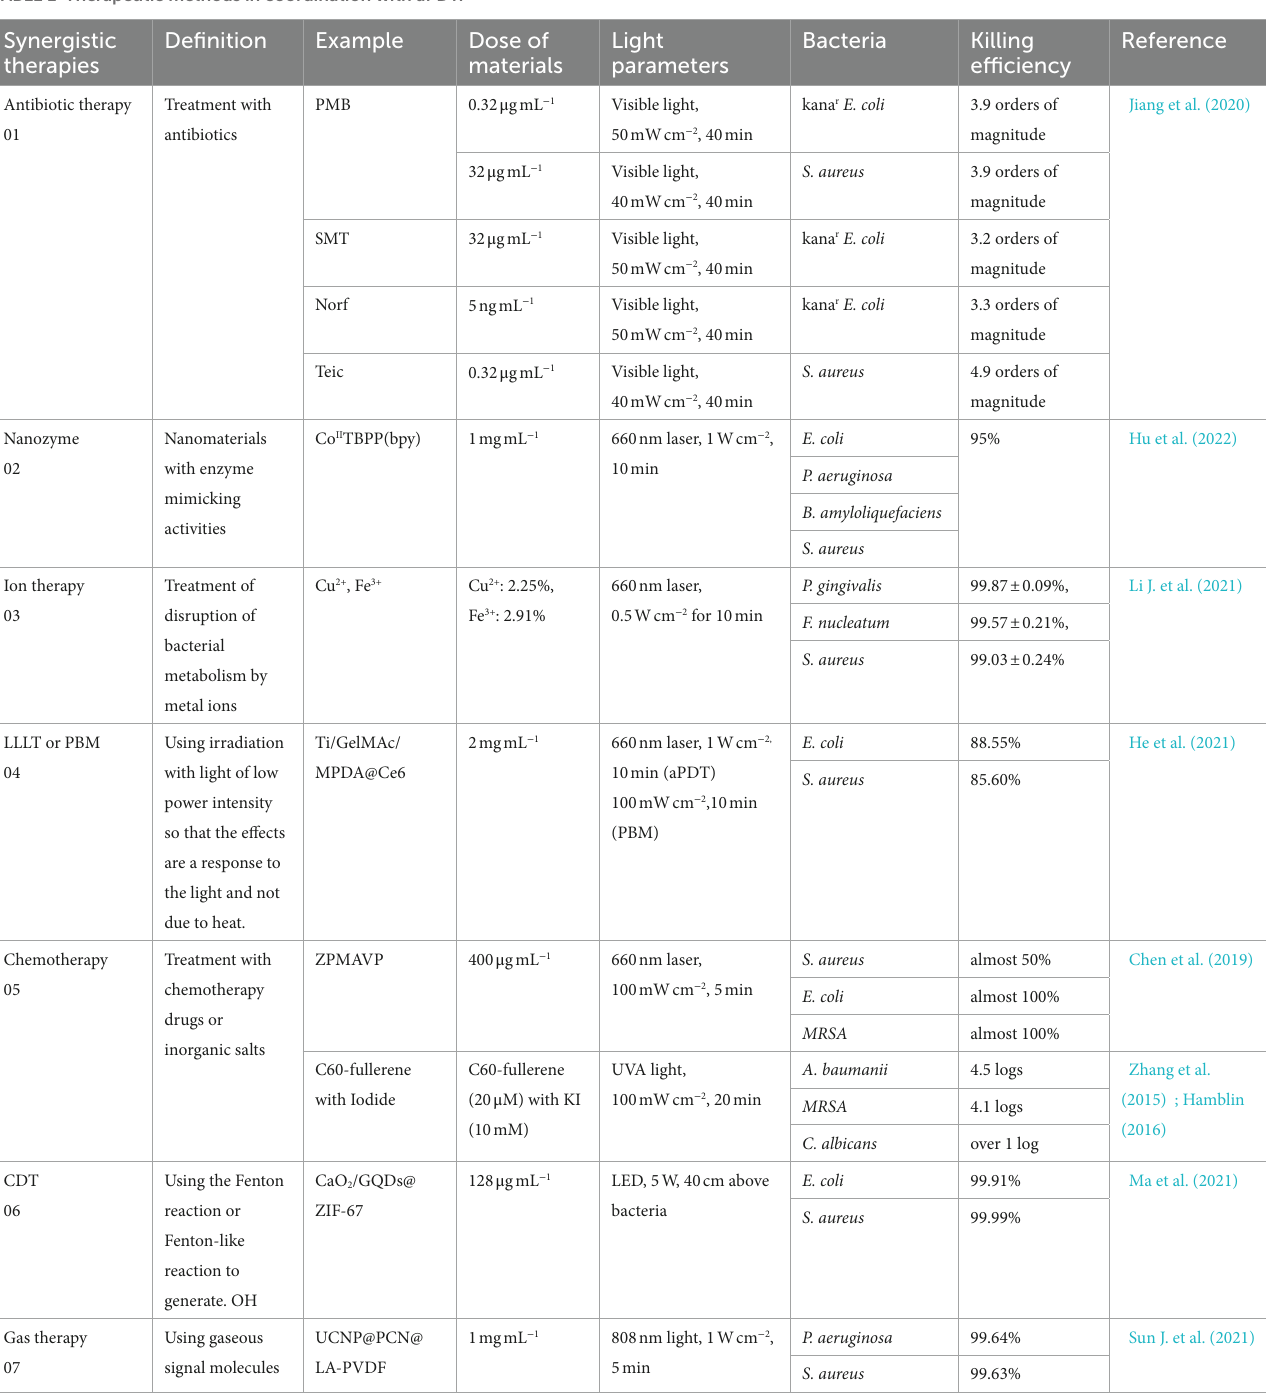
TABLE 1 Therapeutic methods in coordination with aPDT. Synergistic therapies